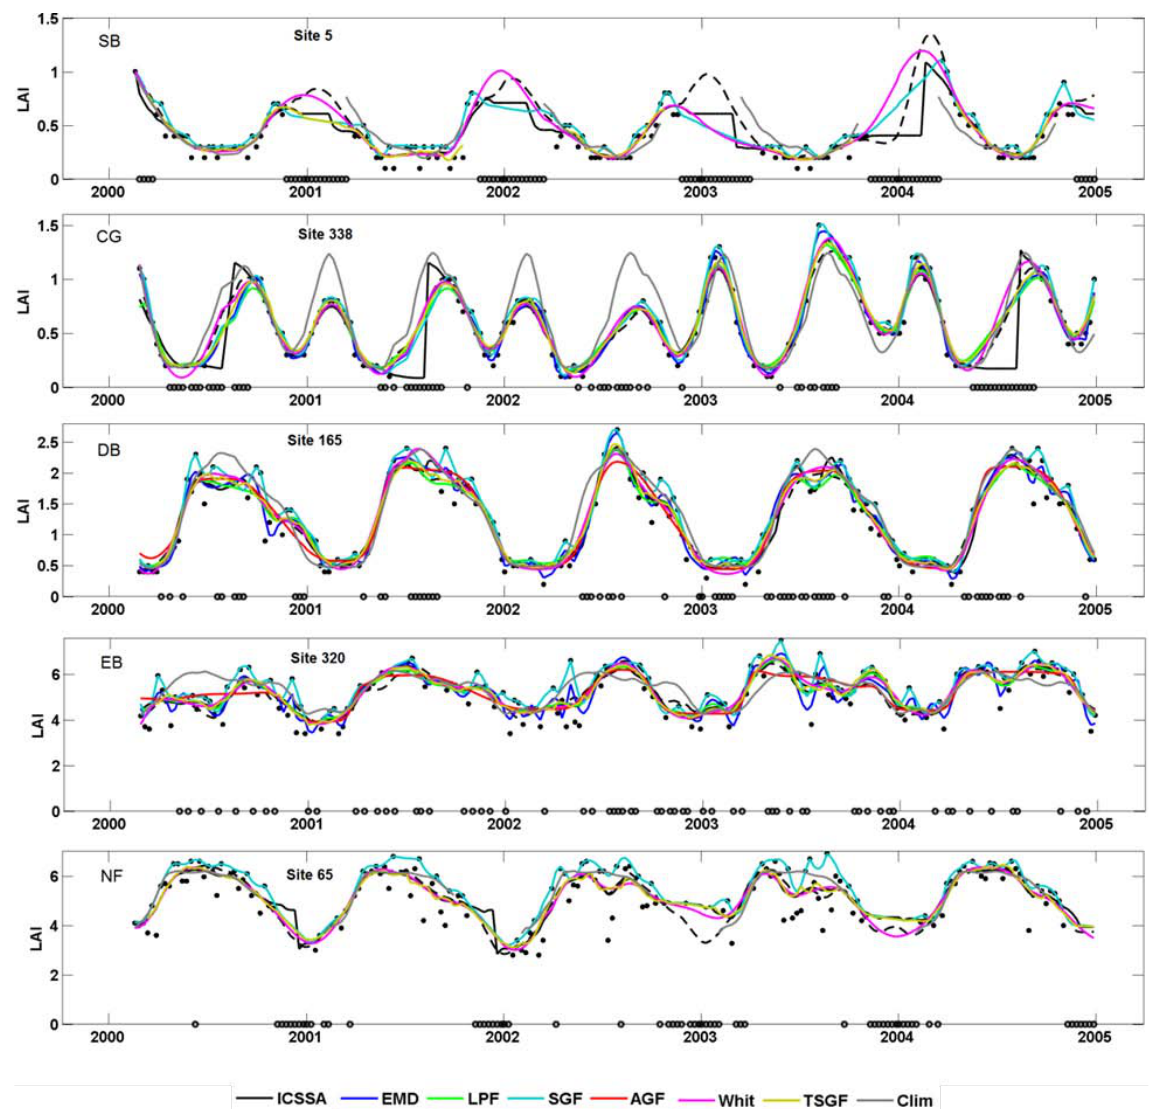
Fig. 5. Time series (LAI rec ) reconstructed by the several methods in presence of medium occurrence of missing data (25% < %gap < 35%). Black dots correspond to LAI comp at the location of observations. Empty circles on the x-axis correspond to the dates of missing data. The dashed black curve corresponds to LAI ref . Note that because of the structure of missing data, EMD, LPF and AGF were not reconstructed for sites 5 and 65, as well as AGF for site